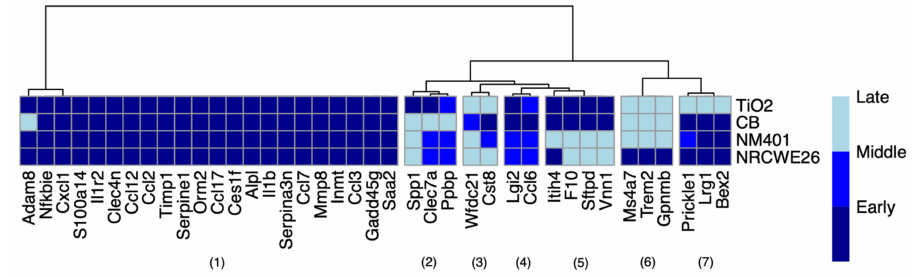
Figure 6. Genes with a dynamic dose-dependent transcriptomic profile in the four ENMs. Colors indicate the dynamic point of departure of the gene with respect to early, middle, and late time points.